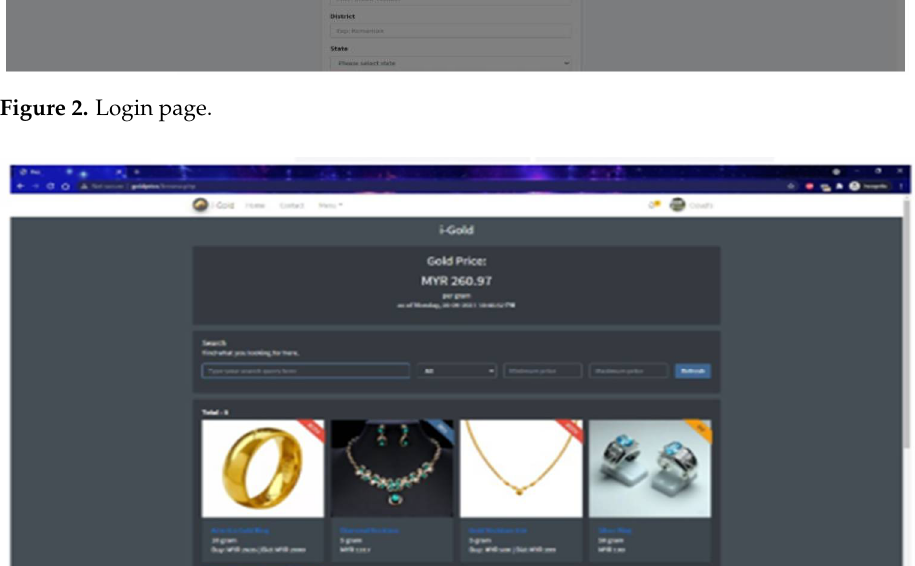
Figure 3. Search page.